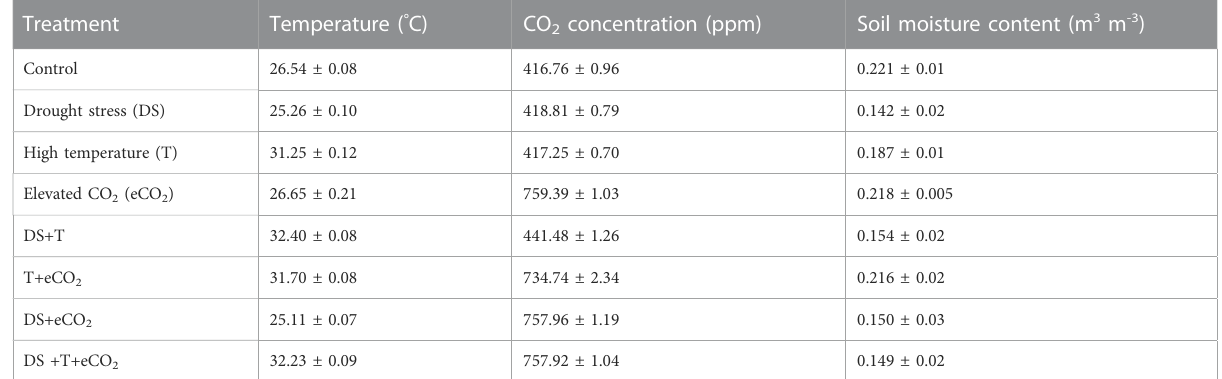
TABLE 1 The treatments mean day and night temperatures, daytime CO 2 , and day and night soil moisture content for each unit. Temperature (T), carbon dioxide concentration (CO 2 ), elevated CO 2 (eCO 2 ), drought (DS), and cultivars (CUL). Values in the mean ± standard deviation of the mean.